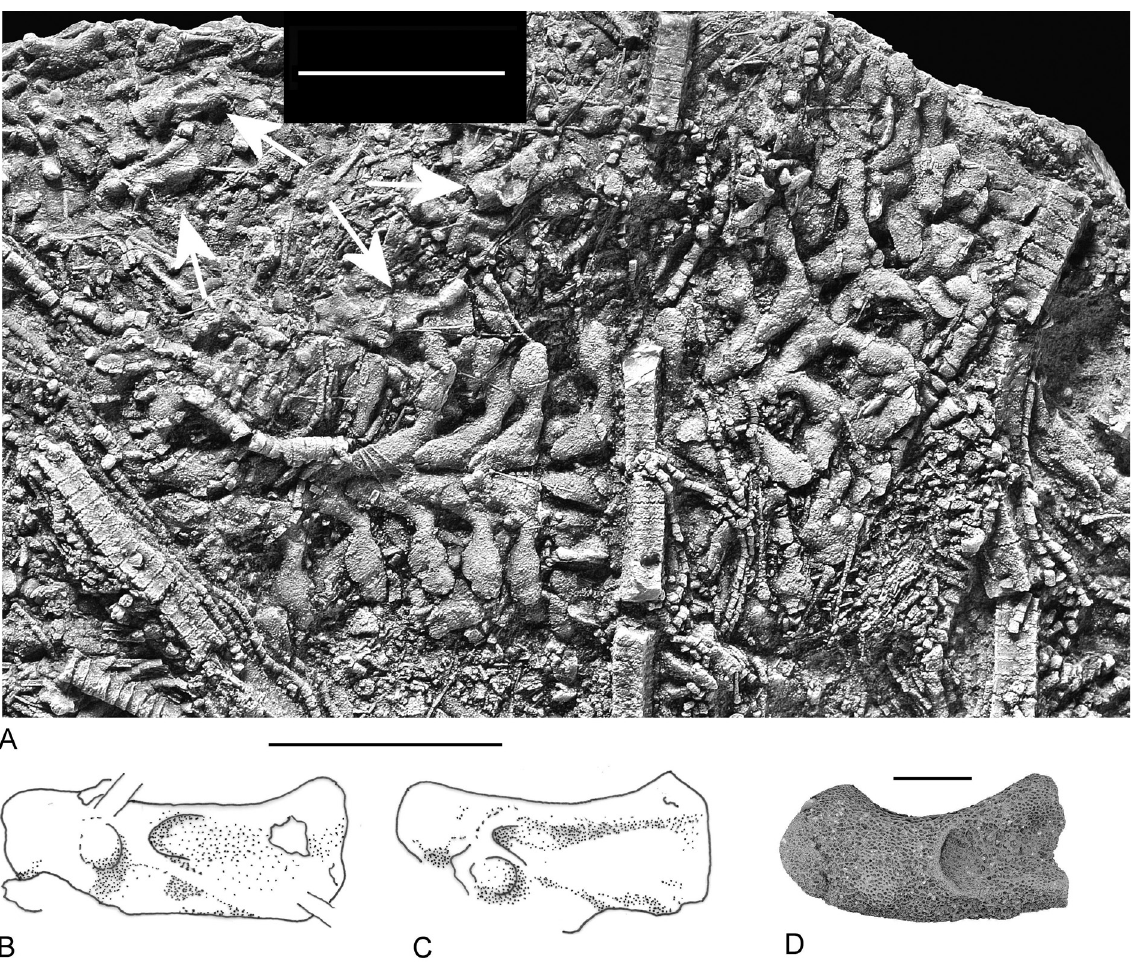
Fig. 15. A–C . Xandarosaster hessi Blake, 1984. A . Holotype slab (NMB M9683), showing